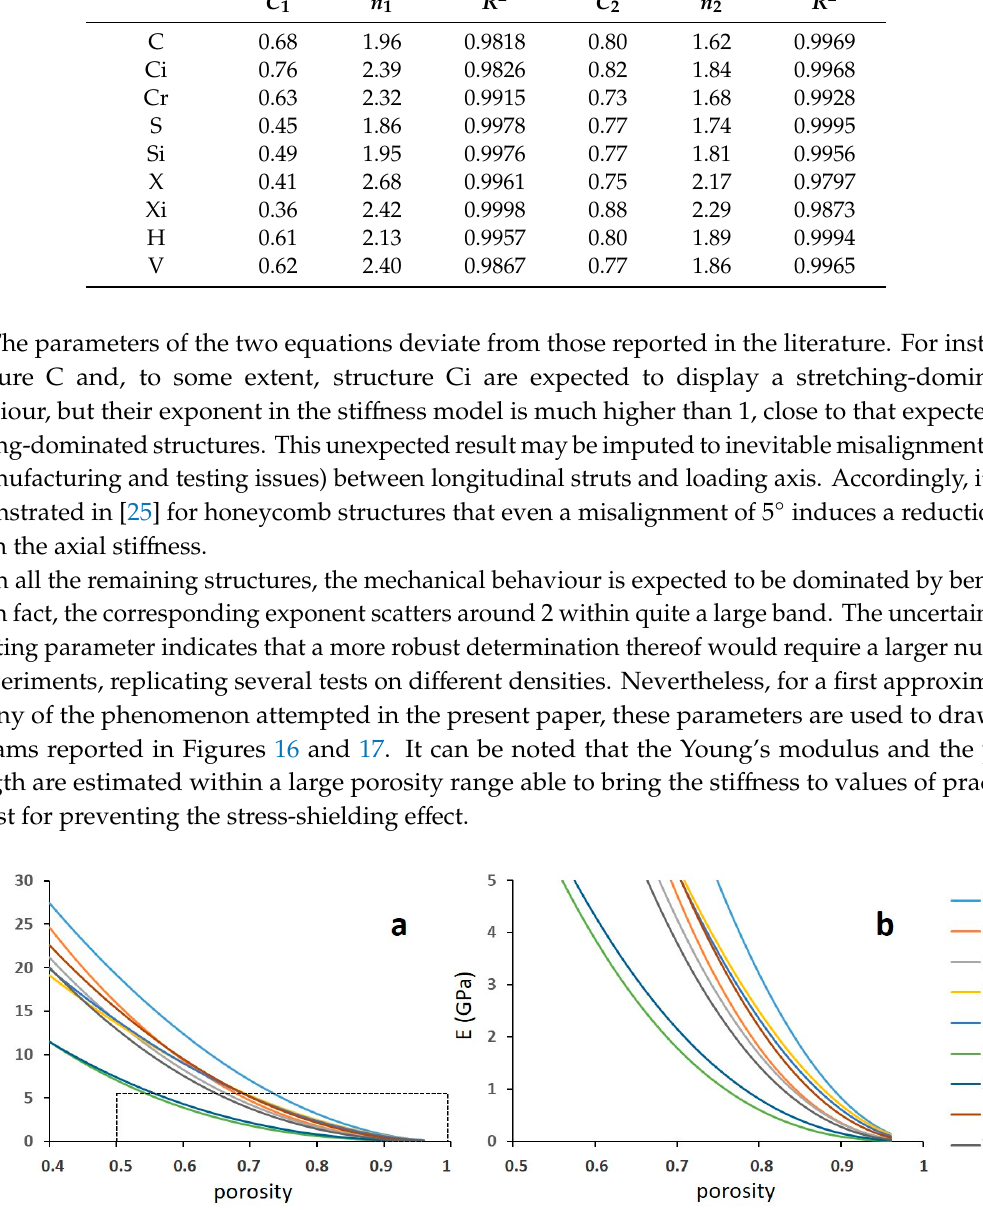
Figure 15. Log–log plot of the Gibson–Ashby model for Young’s modulus and yield strength. The letters refer to structures.